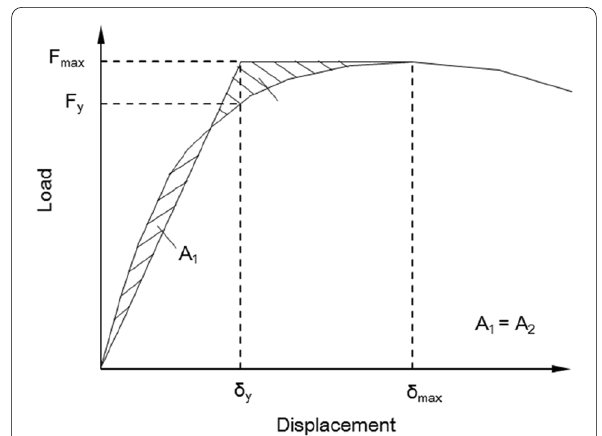
Fig. 15 Determination of the yield point.